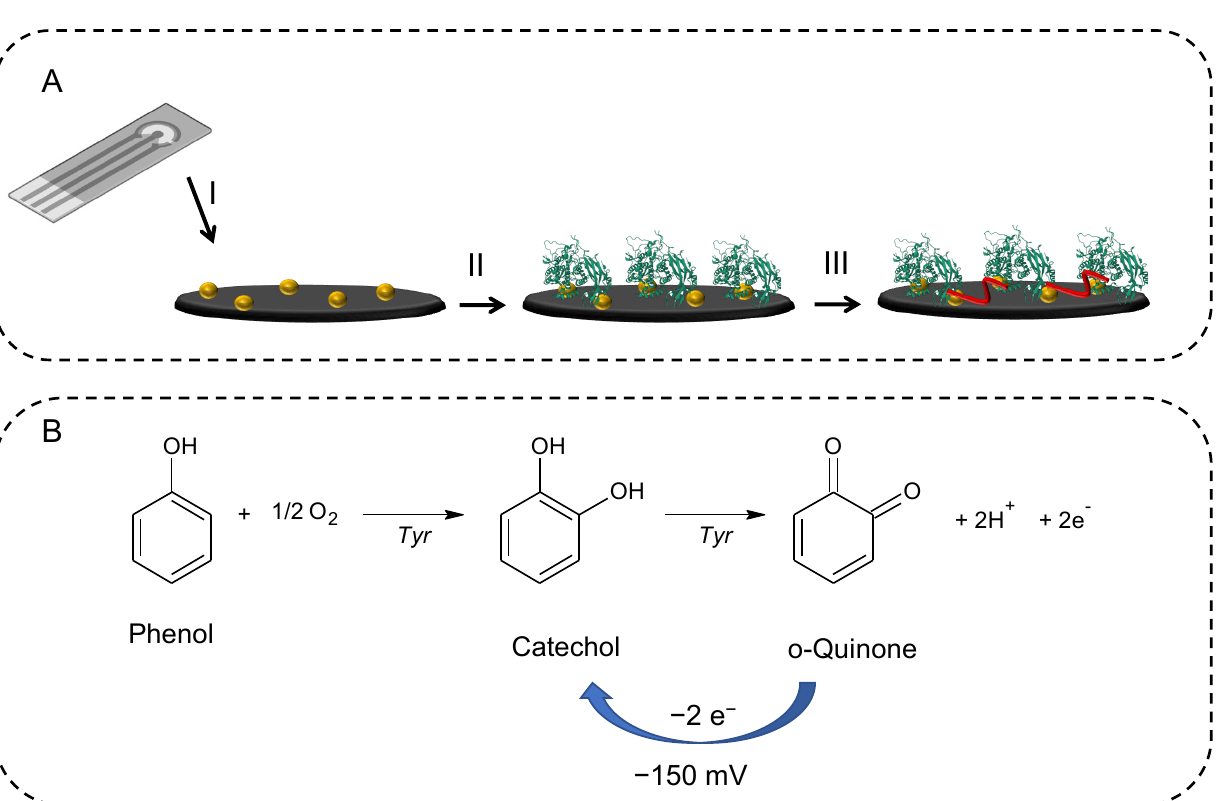
Figure 1. ( A ) Schematic representation of the working electrode modifications: (I) electrogeneration of the AuNPs using a solution of tetrachloroauric acid and subsequent reduction of Au(III) by applying a potential equal to +0.18 V to the working electrode for 50 s, (II) immobilization of tyrosinase enzyme (100 IU/ µ L), (III) cross-linking reaction using a 25% gluteraldehyde solution. ( B ) The oxidation process of phenol to ortho-quinone catalyzed by